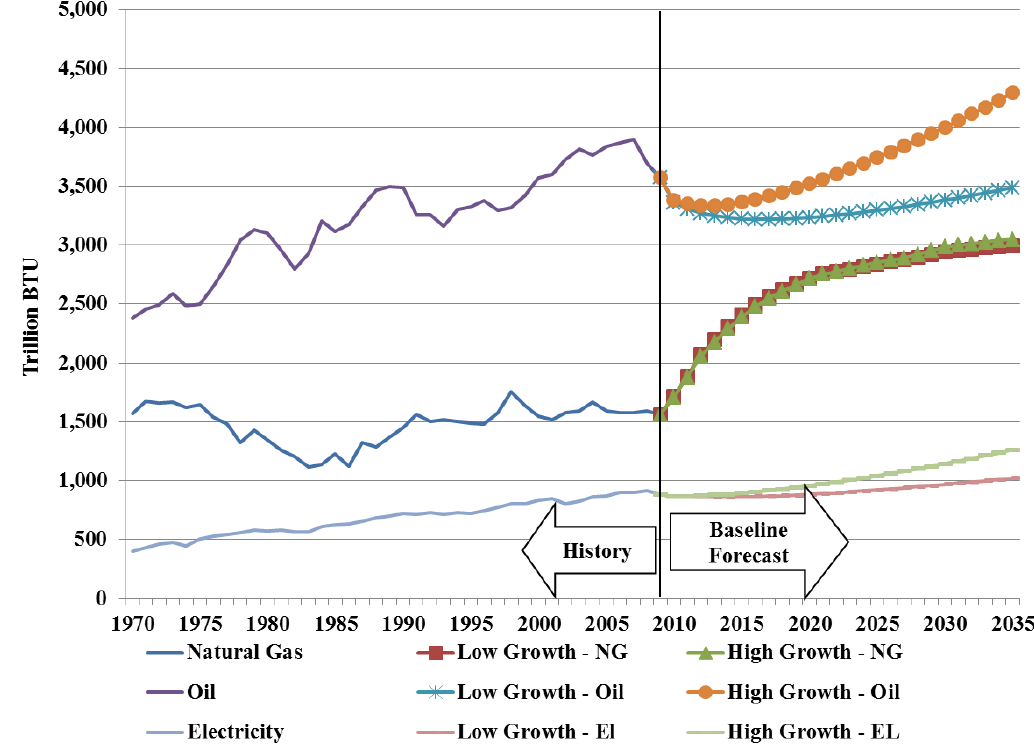
Figure 8. Historical and projected oil, natural gas, and electricity